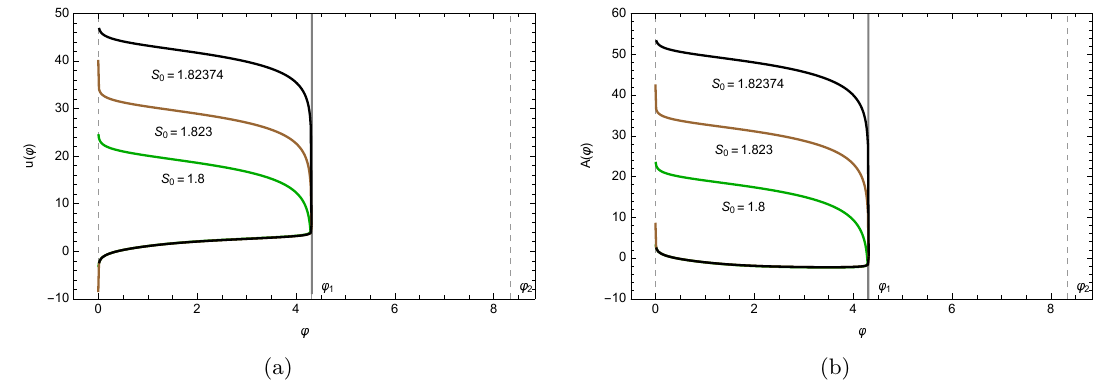
Figure 37 . The behavior of (a): the holographic coordinate and (b): the scale factor at ϕ 0 = 3 . 5 as the flow solutions in type W LL solution exists.